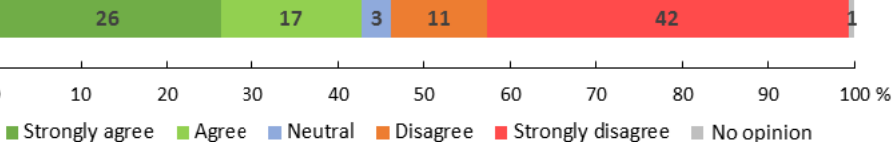
Figure 5. Opinions of respondents (n = 145) on new mining activities in the Hannukainen/Rautuvaara region. Table 4. Chi-square statistics for respondents’ opinions on statements related to new mining activities in the Hannukainen/Rautuvaara region. See Figure 5 for full statements. Relationships between opinions (agree/disagree) and gender, age, relationship to the region, respondent’s work in the mining industry, and respondent’s relative(s) work in the mining industry were examined. Gender